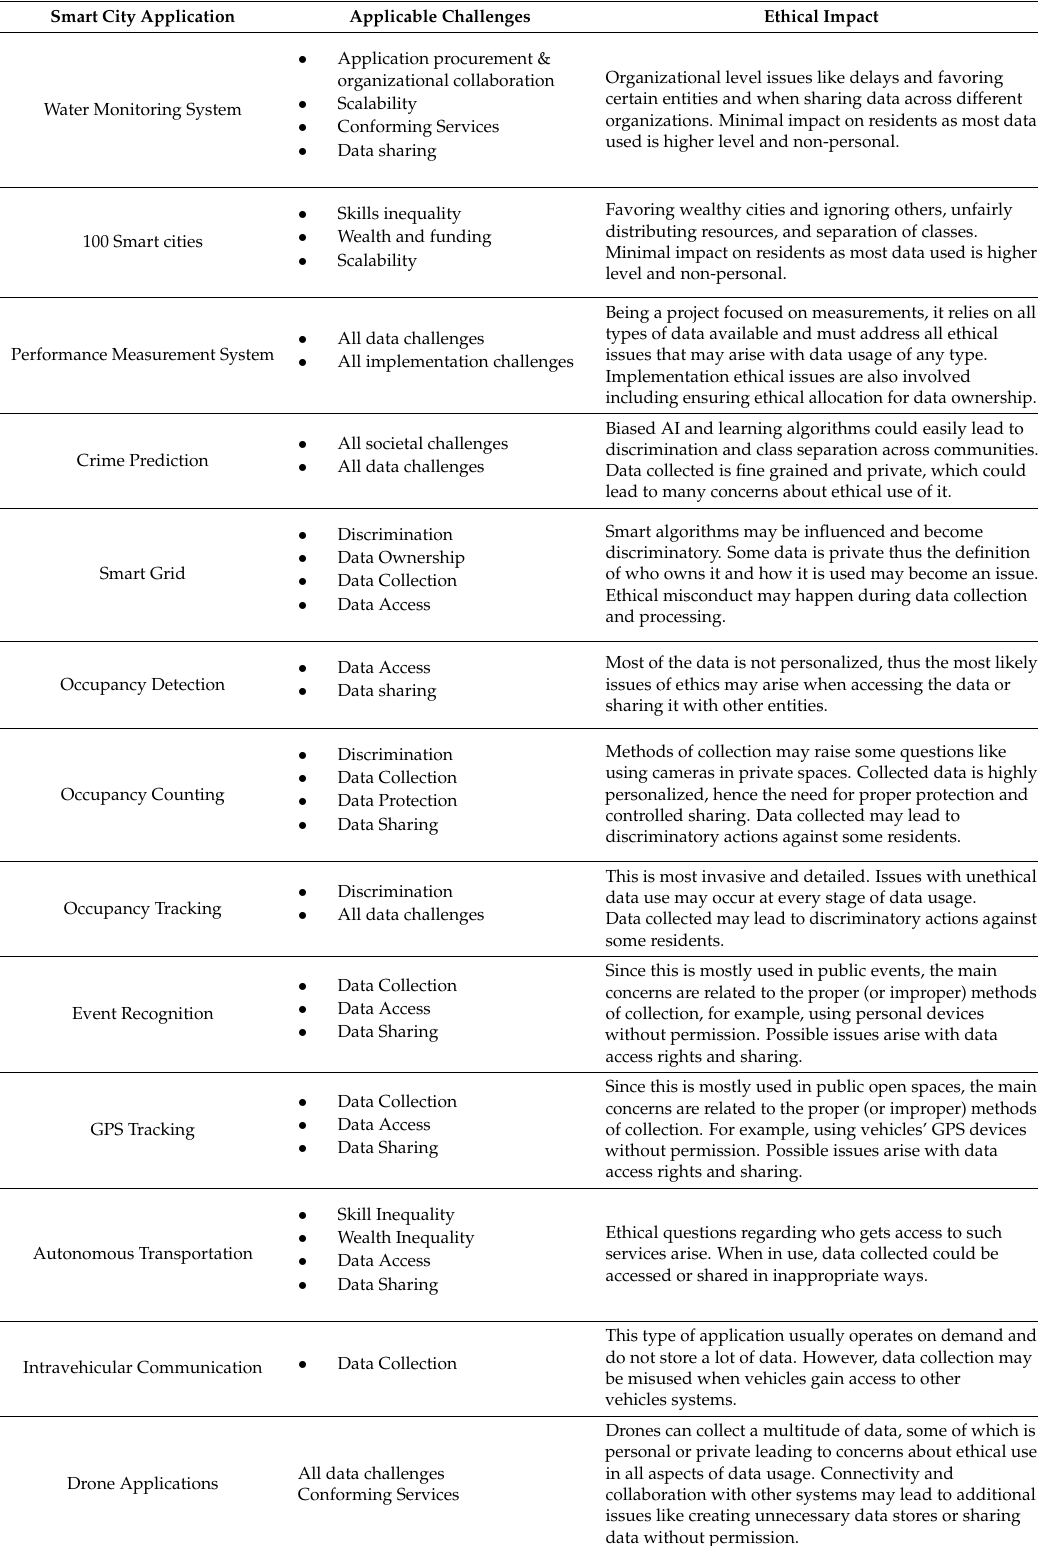
Table 1. Ethical challenges in relation to the smart city applications